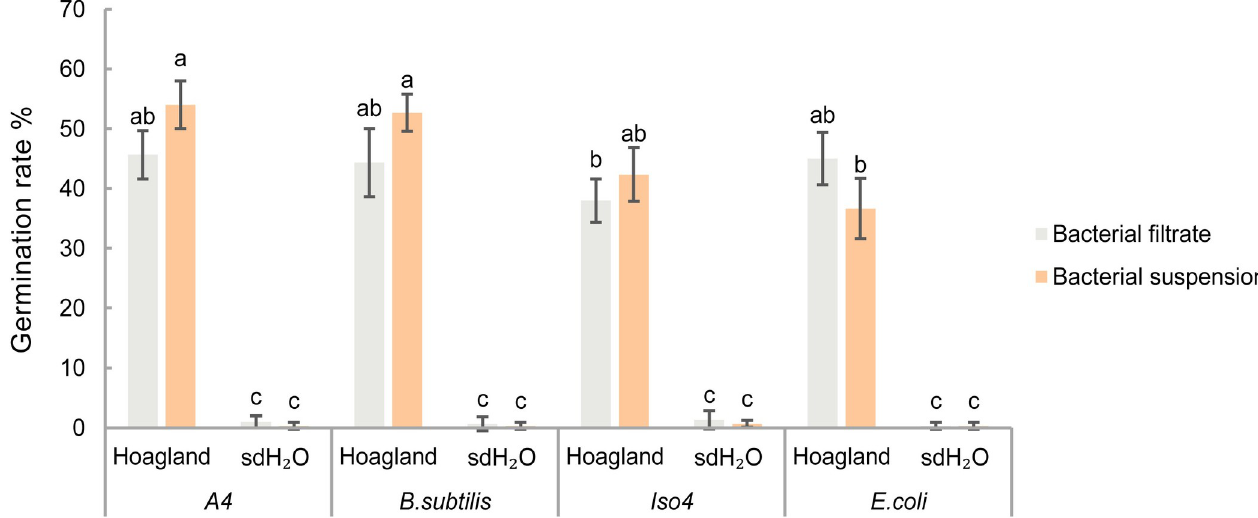
Fig 2. Germination rates of non-sterile resting spores of P . brassicae incubated with different bacterial suspensions or filtrate with Hoagland solution or sdH 2 O after 7 days. Error bars represent standard deviations. Different letters represent significant differences among the treatments (Tukey test. P < 0.05, n = 3).